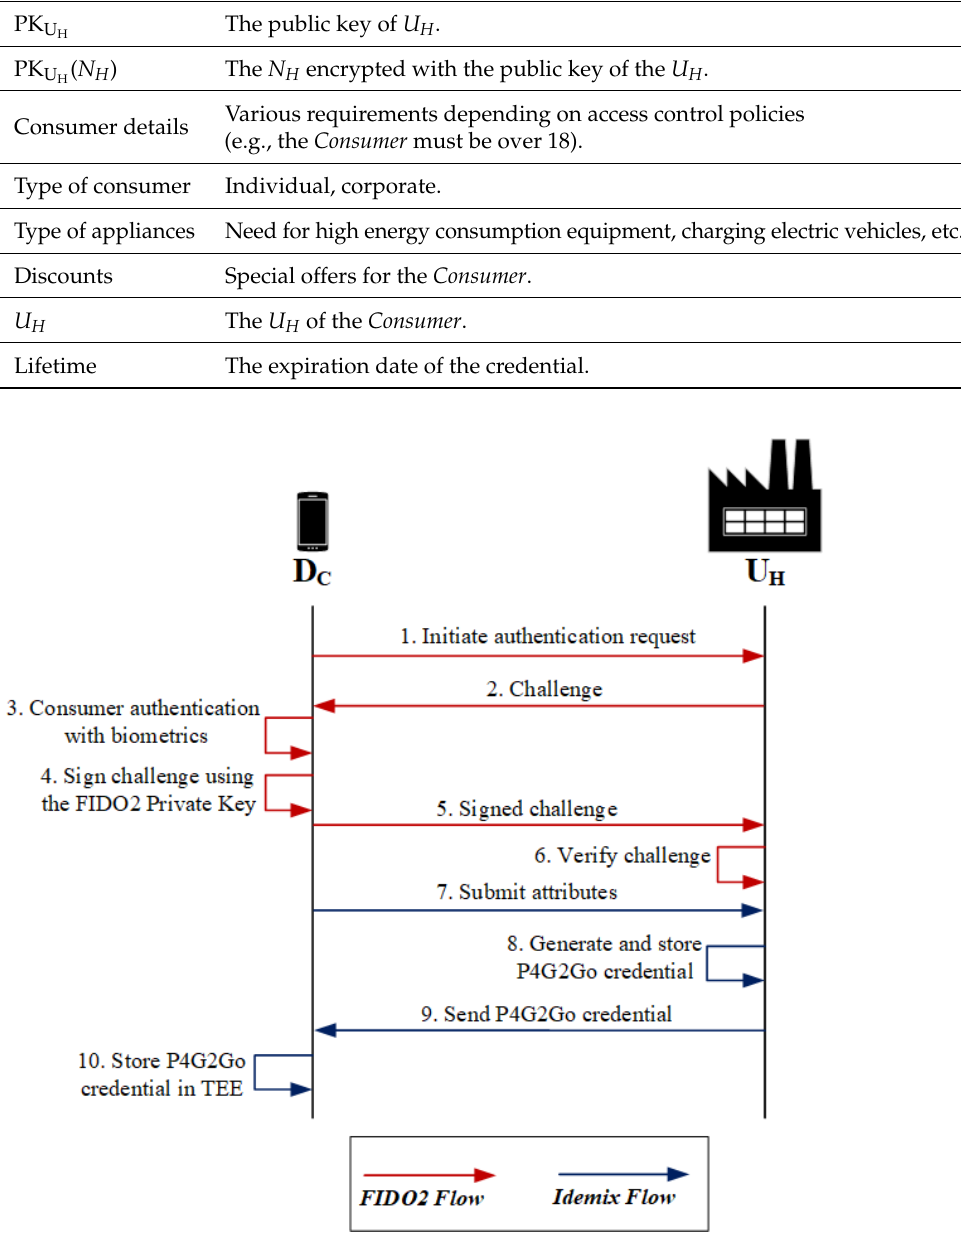
Table 2. P4G2Go credential attributes.